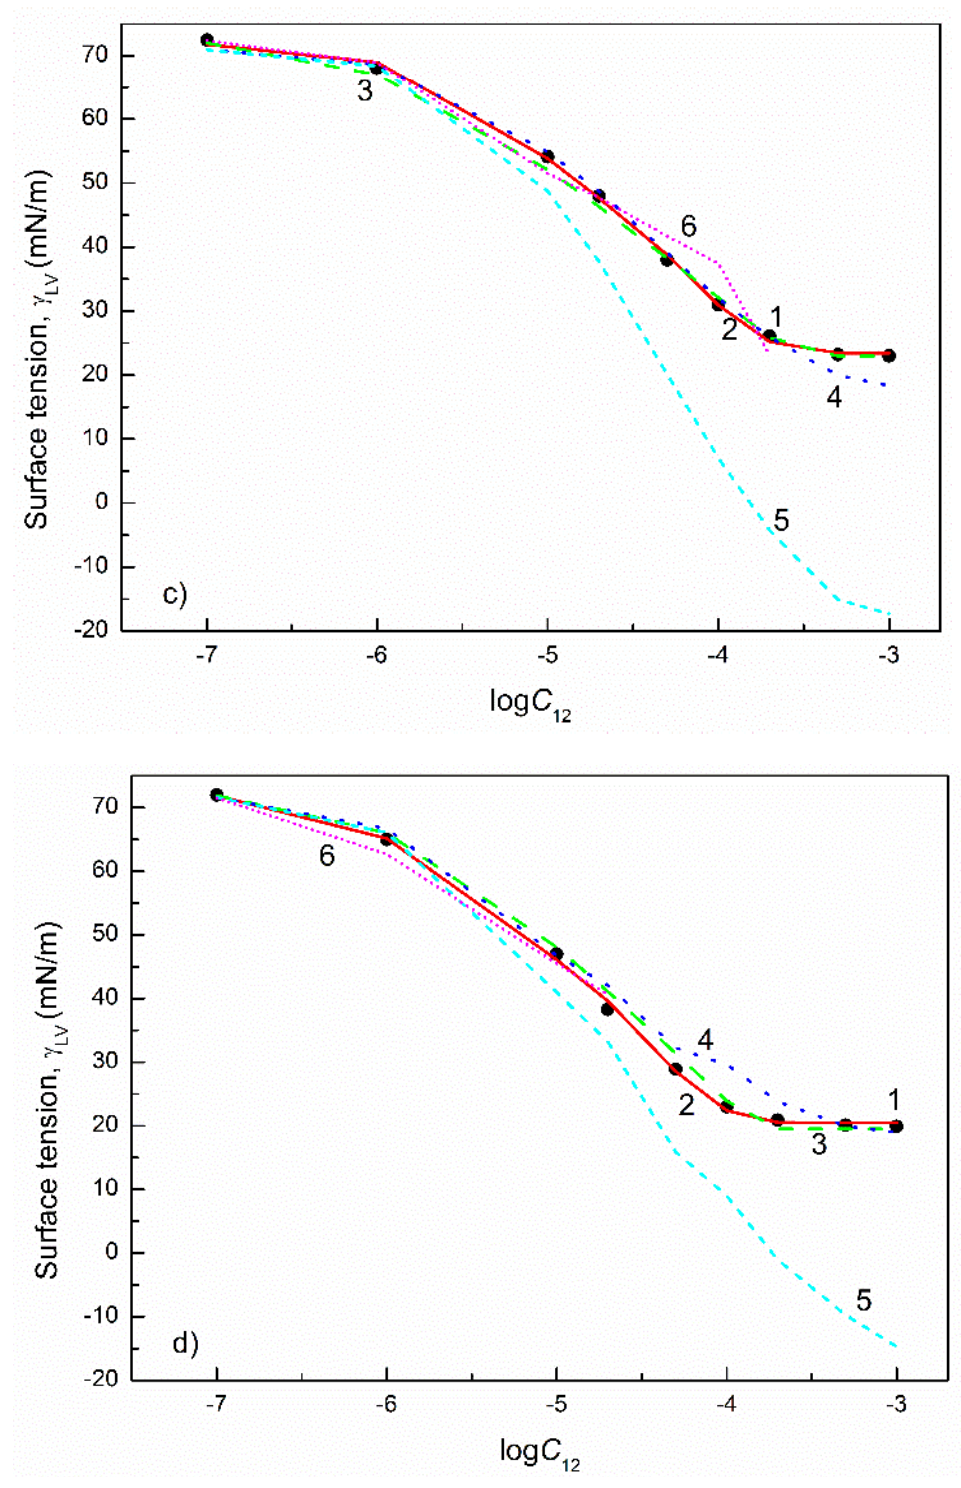
Figure 11. A plot of the surface tension ( γ LV ) of the aqueous solutions of FC1+TX165 mixtures at the FC1 mole fraction in the bulk phase ( α ) equal to 0.2 ( a ) and 0.8 ( b ) as well as FC2+TX100 mixtures at the FC2 mole fraction in the bulk phase equal to 0.2 ( c ) and 0.8 ( d ) vs. the logarithm of the mixture concentration ( logC 12 ). Points 1 correspond to the measured values [29], curves 2–6 correspond to the values calculated from the exponential function of the second order (Equation (2)), Szyszkowski equation (Equation (3)), Fainerman and Miller equation (Equation (11)), independent adsorption (Equation (10)) and Joos equation (Equation (13)), respectively.